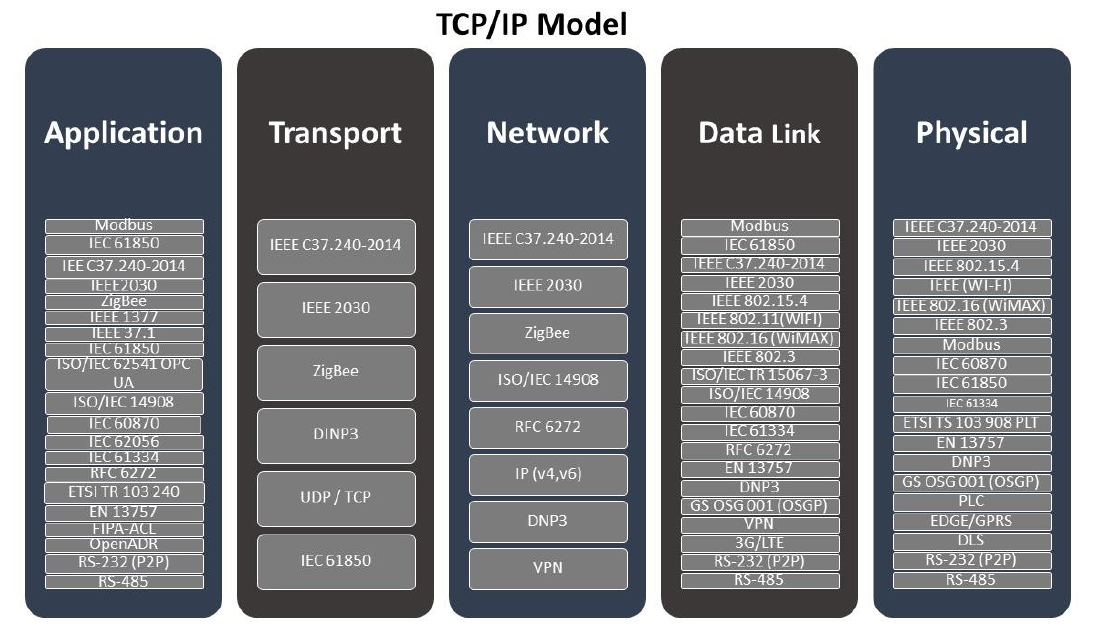
Figure 9. Communication protocols based on TCP/IP model.